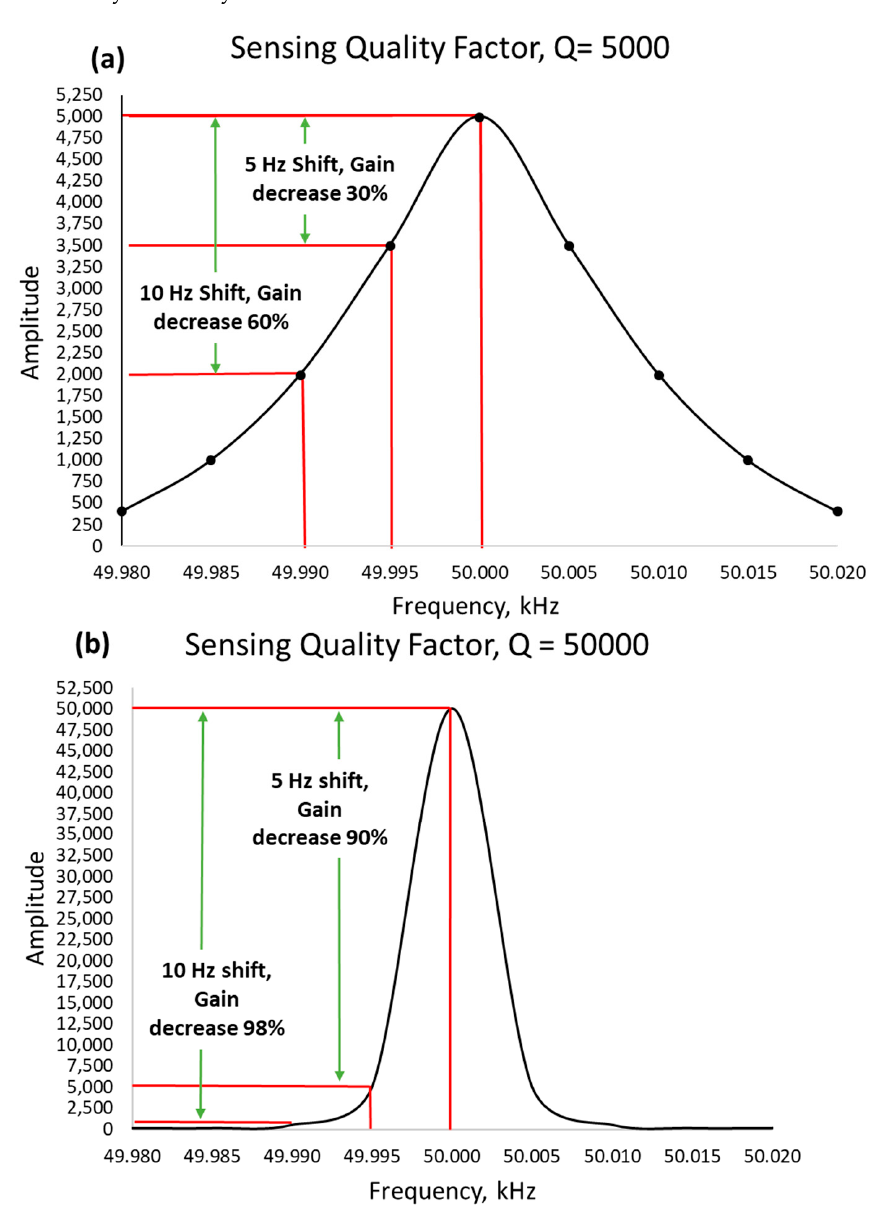
Figure 4. Response gain decrement of low-quality factor vs high-quality factor sensing response. ( a ) shows a response for low quality factor and ( b ) shows a response for high quality factor.